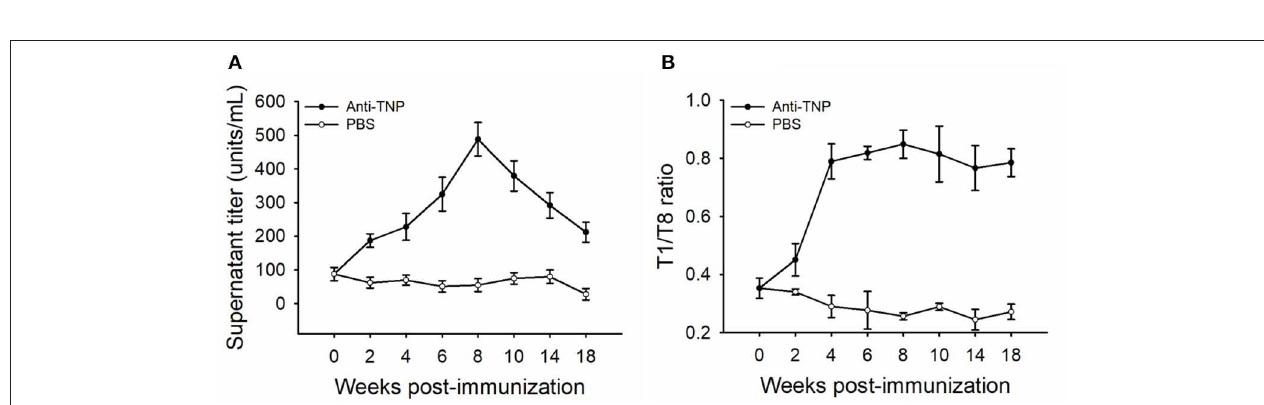
FIGURE 4 | Kinetics of TNP-specific LLPCs (HU-insensitive, in vitro D15). The average number per 10 6 leukocytes (A,C) and the total number in each tissue (B,D) detected in peripheral blood, spleen, and anterior kidney ( n = 5) immunized with TNP-KLH (A,B) and PBS (C,D) . Data represent the mean ± SD of five individual fish at each time point time point and are representative of three independent experiments.